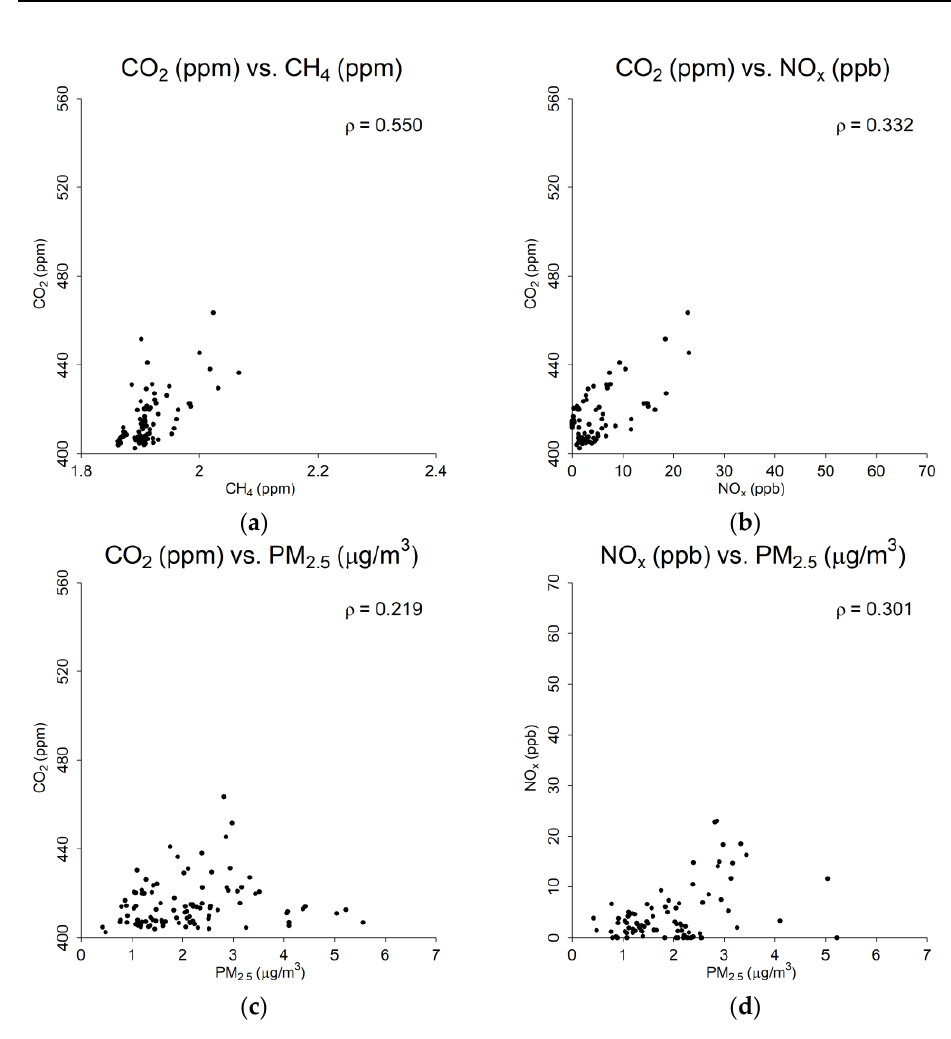
Figure 7. Van pollutant readings comparisons for Bonneville Phase 1 campaign (13–27 September